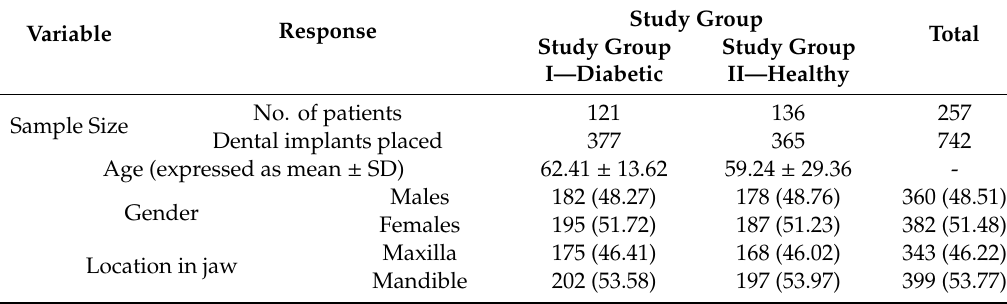
Table 2. Frequency distribution table showing the descriptive characteristics of the sample. Variable